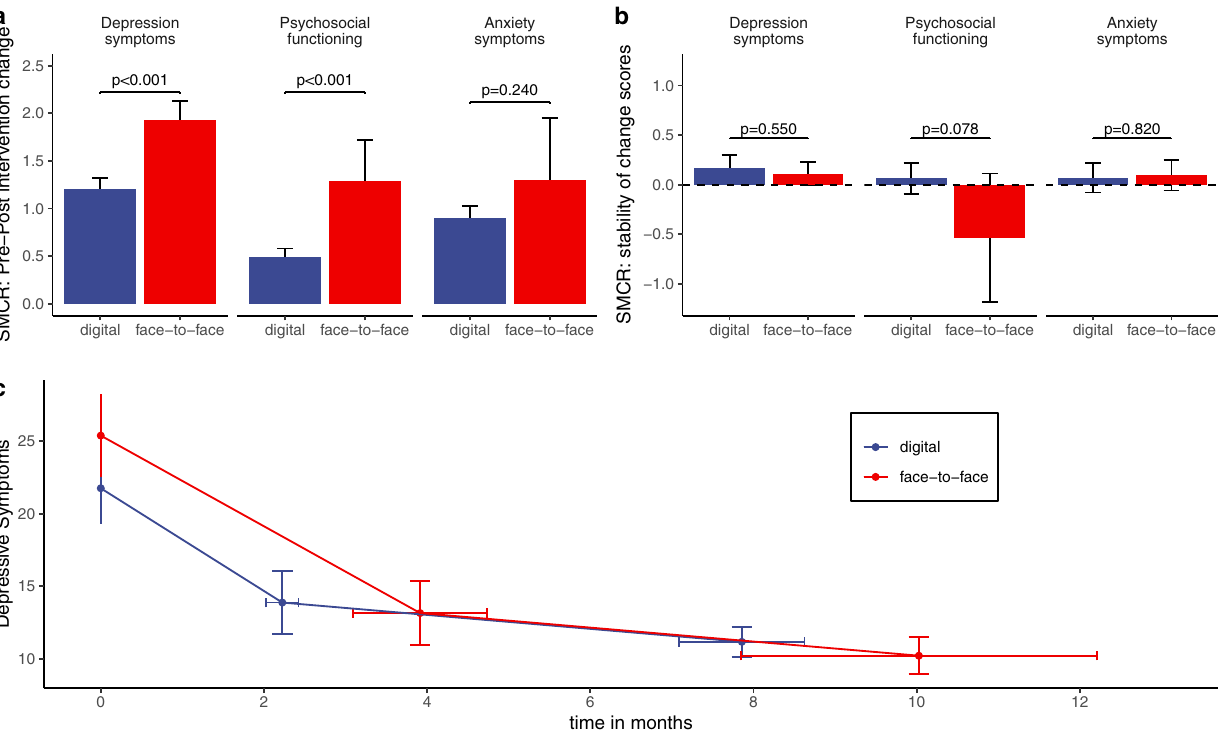
Fig. 2 Results of meta-analyses investigating the effect of digital and face-to-face CBT interventions. a Effects of CBT on anxiety symptoms, depression symptoms and psychosocial functioning. b Results of the meta-analyses of long-term stability of treatment gains. c Subanalysis of samples based on depression severity based on BDI-II scores. P values indicate signi fi cance of differences between digital and face-to-face interventions tested by moderator analysis. Error bars indicate lower and upper limits of the 95% con fi dence interval. Effect sizes and p values are presented without correction for differences in patient samples or study design characteristics and without correction for potential publication